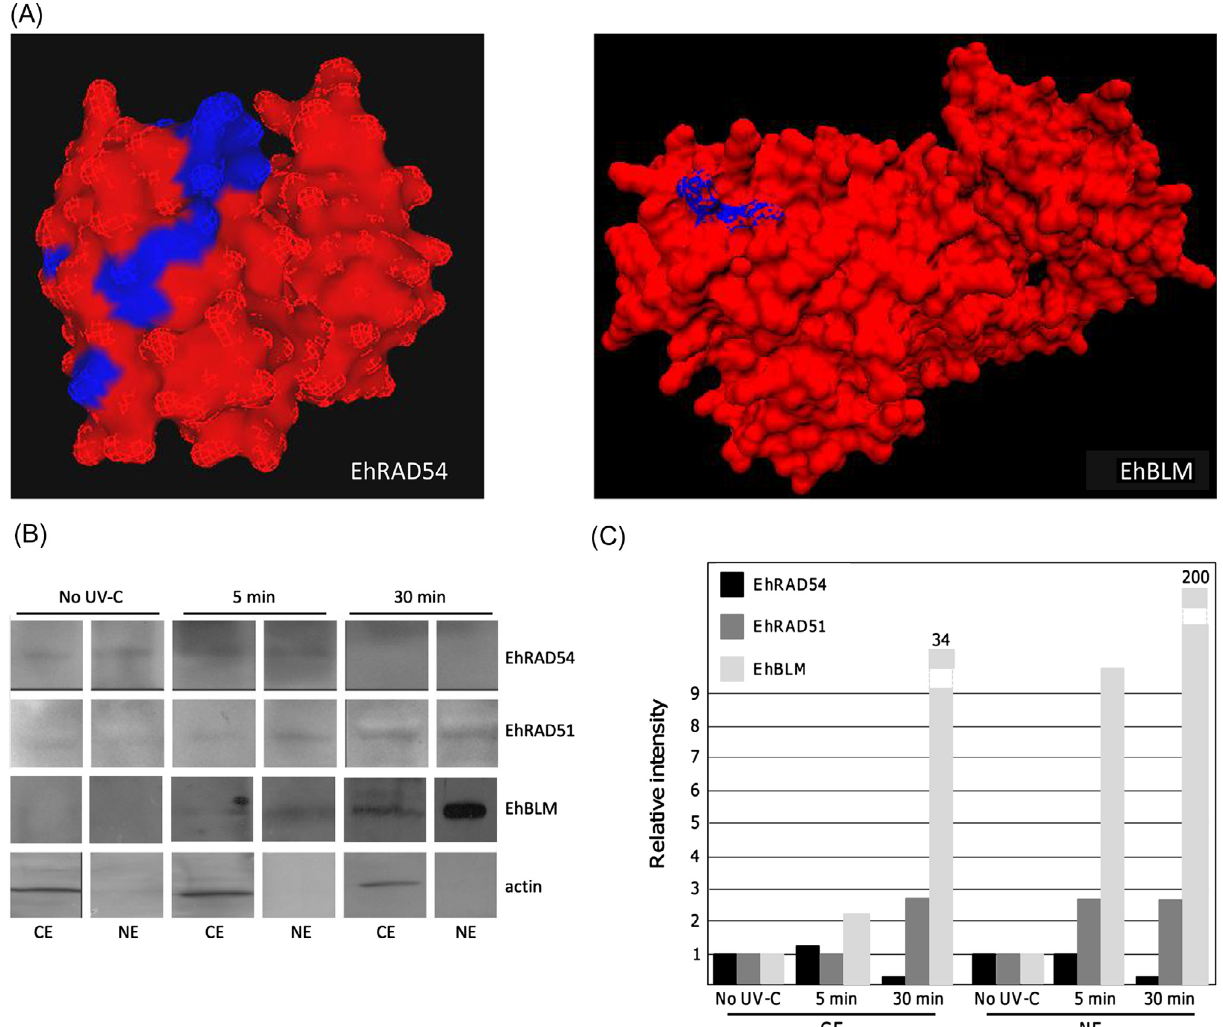
Figure 2. Immunodetection of EhRAD54, EhRAD51, and EhBLM. (A) Localization of EhRAD54-pepA and EhBLM-pepB peptides in the 3D model of each protein. (B) Western blot assays of cytoplasmic (CE) and nuclear (NE) extracts from trophozoites without irradiation (No UV-C) or at 5 min or 30 min after DNA damage. The name of each inmmunodetected protein is indicated at the right. Actin was used as control. (C) Densitometry analysis of bands revealed in (B). Pixels corresponding to cytoplasmic actin were taken as 100% at each time after DNA damage, and used to normalize data. The relative expression of each protein is expressed using the protein amount before UV-C exposure as a reference. Results in (B) and (C) are representative of three